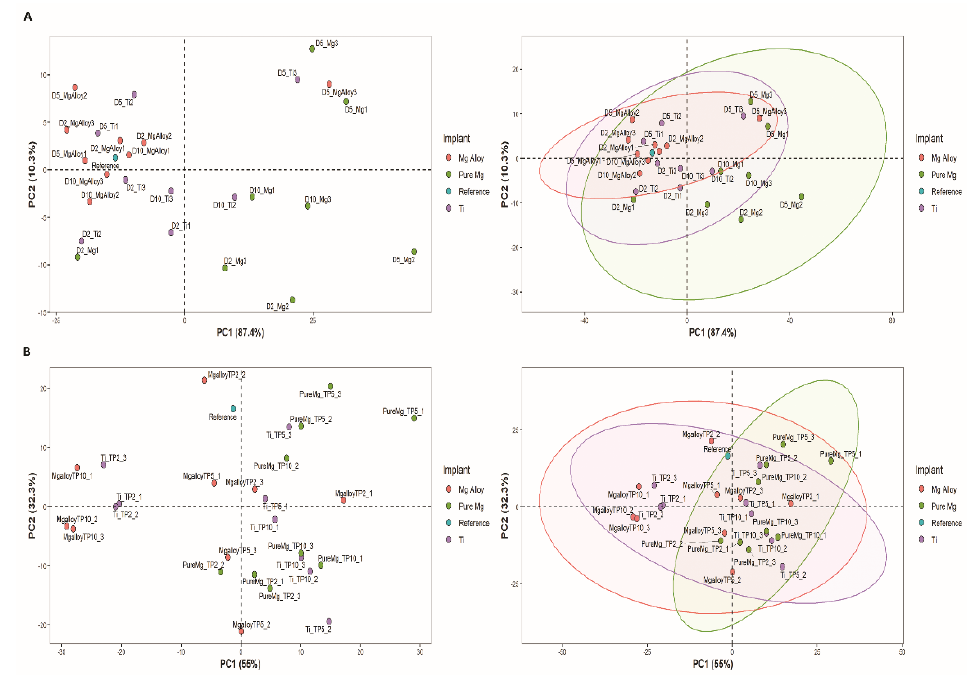
Figure 2. Principal component analysis (PCA) score plots, where samples are coloured by implant type. ( A ) shows the PCA score for absorption spectra ranges from 600 to 1000 nm in wavelength and its corresponding ellipses on the same score plot showing the 95% confidence interval explaining the correlation of the similarity and differences with an increase in the time point; the samples contributed more toward PC1; ( B ) shows the PCA score plot for absorption spectra ranges from 1000 to 2000 nm and its corresponding ellipses on the same score plot showing the 95% confidence interval explaining the correlation of the similarity and differences with an increase in the time point; the samples contributed more toward PC1 except the Mg alloy.